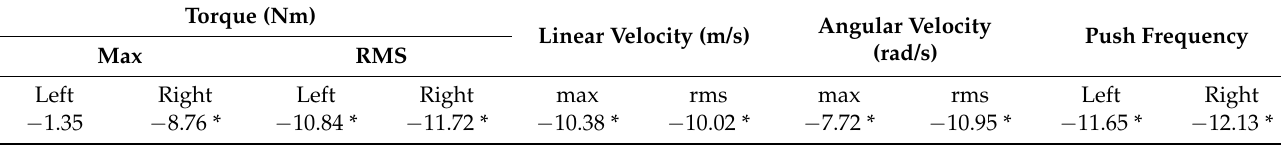
Table 7. Z-value Wilcoxon signed-rank tests (N =